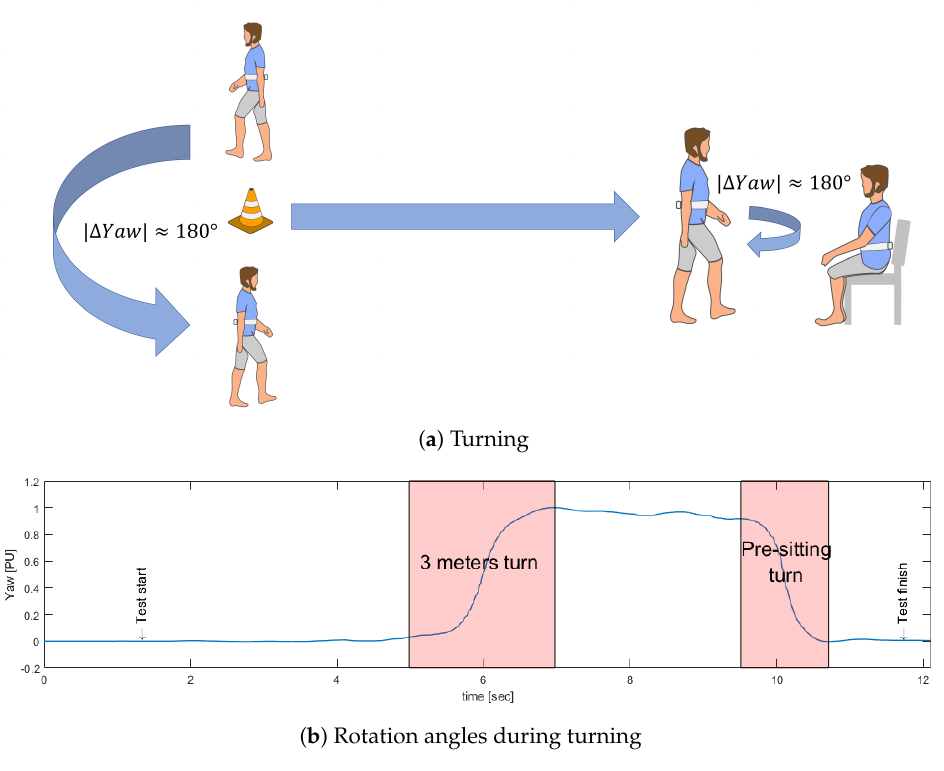
Figure 8. Turning events identification using Yaw .